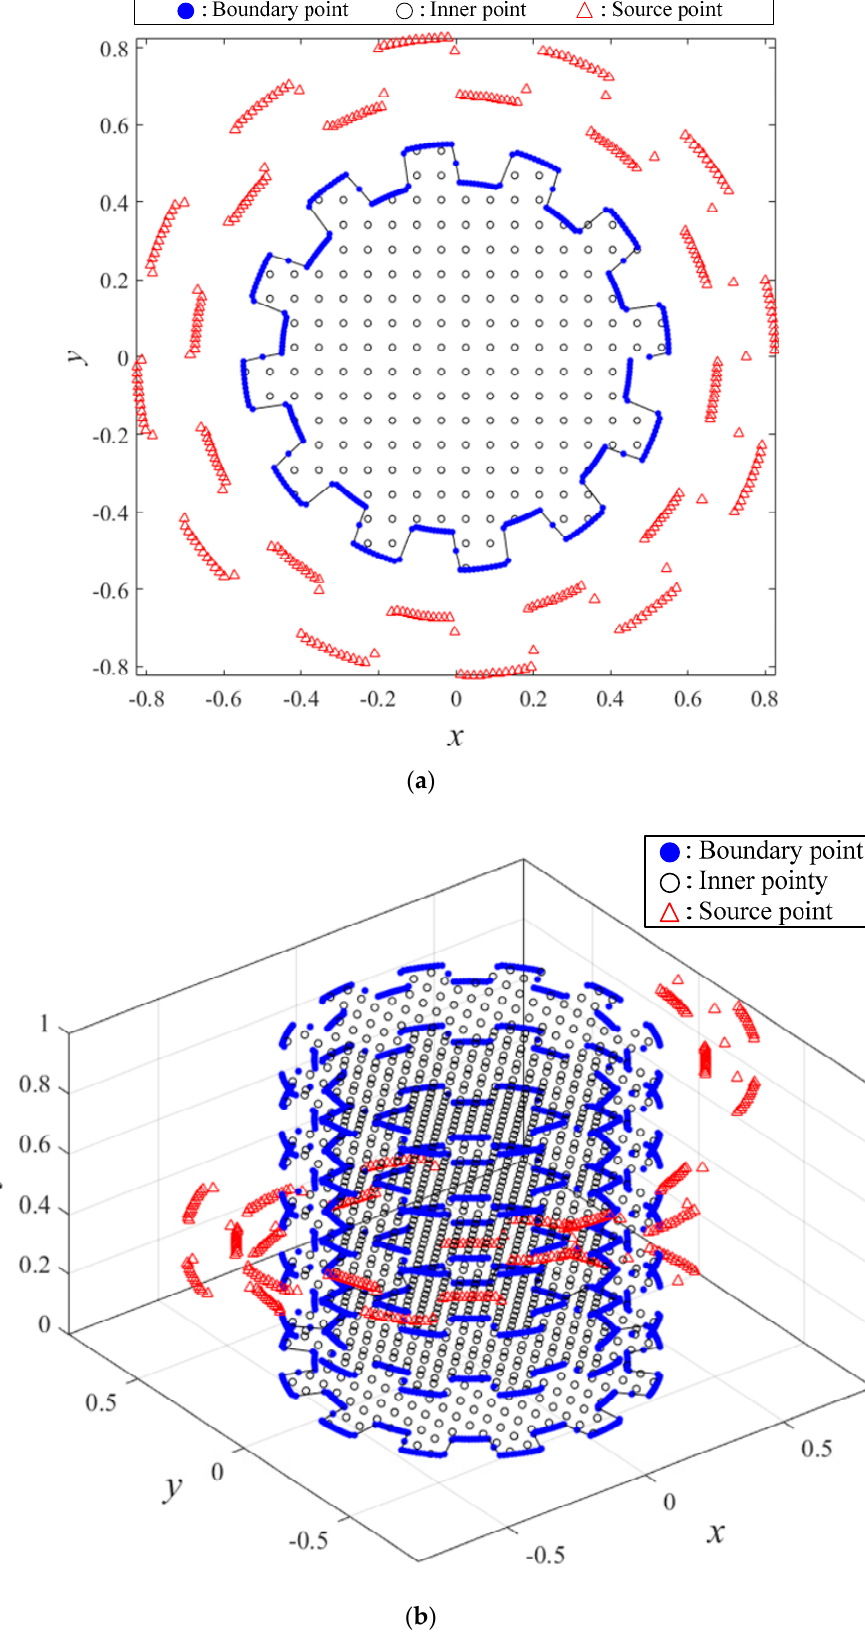
Figure 12. Collocation scheme of the proposed approach for example 4.1 projected on ( a ) an x – y plane and ( b ) space–time coordinates.